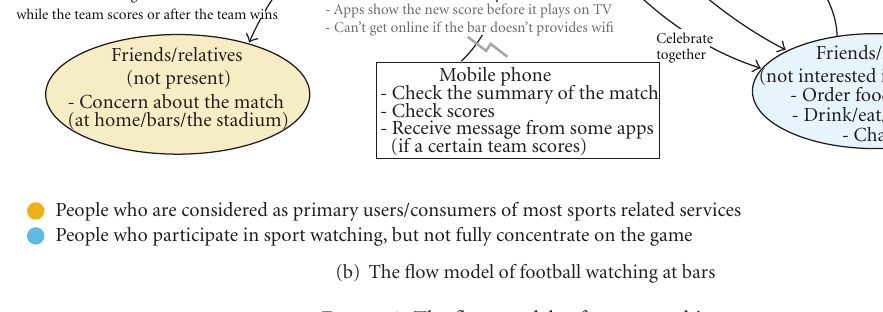
Figure 3: The flow models of sport